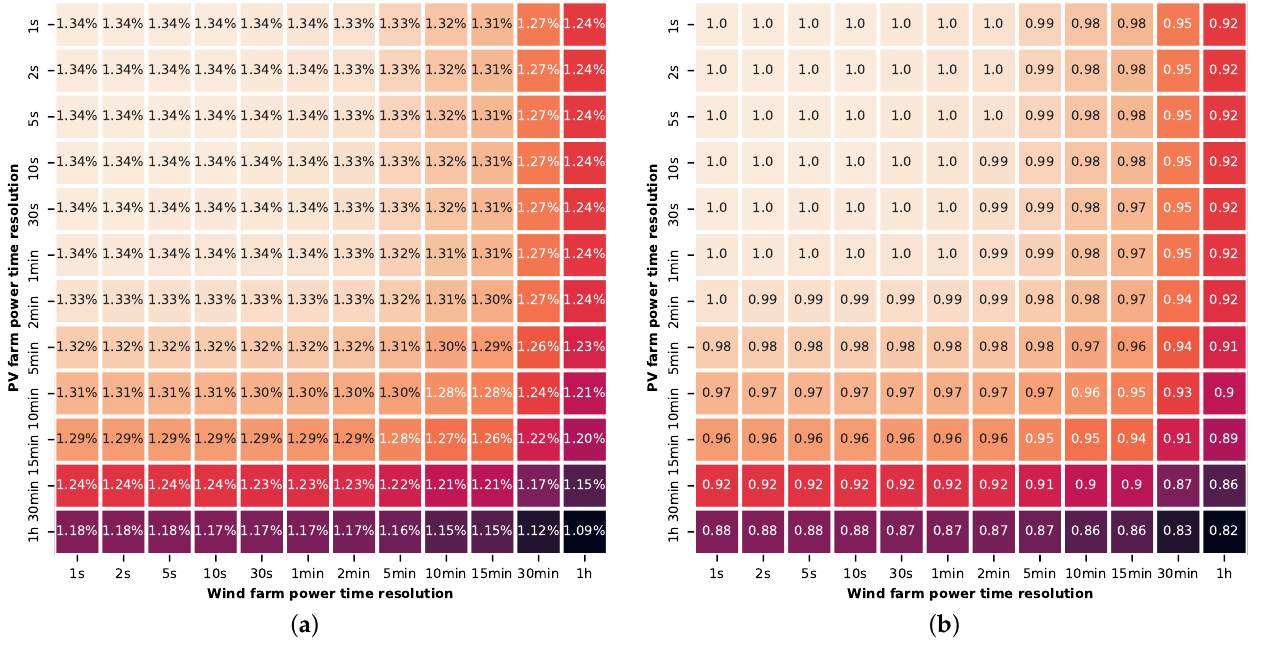
Figure 10. Curtailment losses for winter months (January and February) represented as ( a ) Percentage curtailment losses and ( b ) Relative curtailment losses to 1 s wind and solar PV time